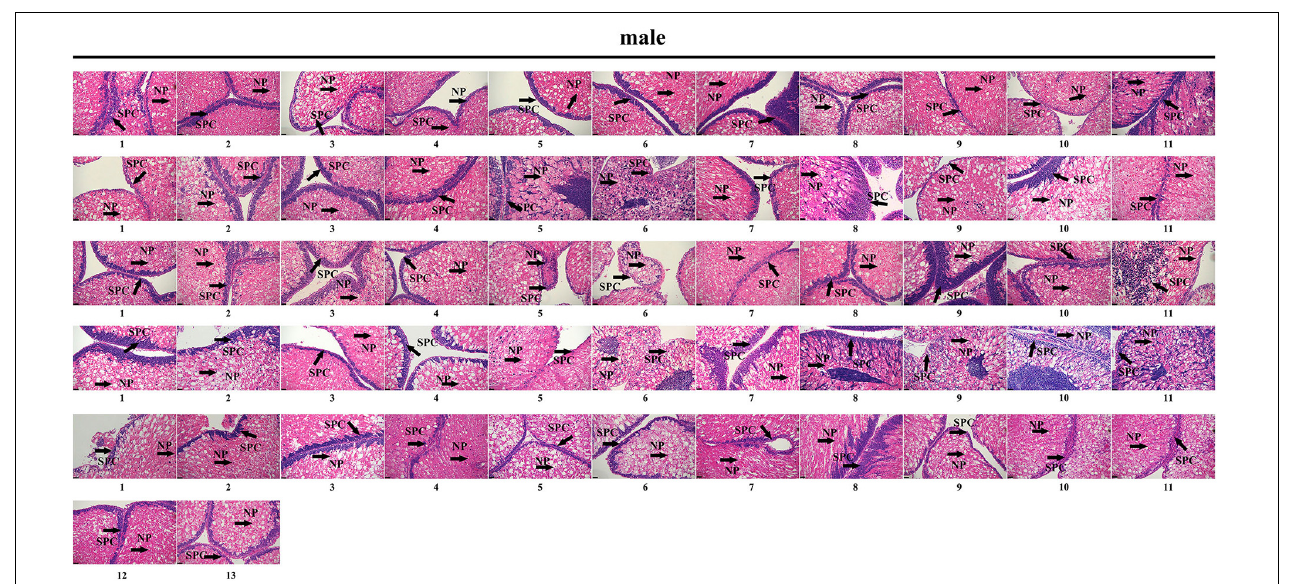
FIGURE 3 | Identification of 38 females by histological detection of gonads in the breeding population. NP, nutritive phagocytes; Oo, oogonia.